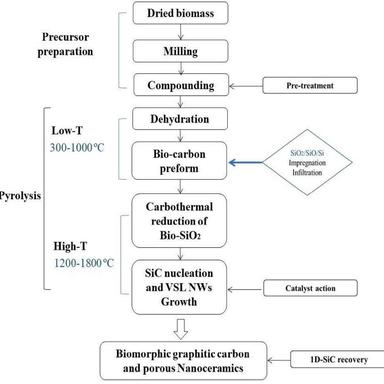
Schematic representation of the core processing and manufacturing steps required for the manufacturing of Bio-SiC Nanoceramics from biomass precursor via carbothermal reduction method.